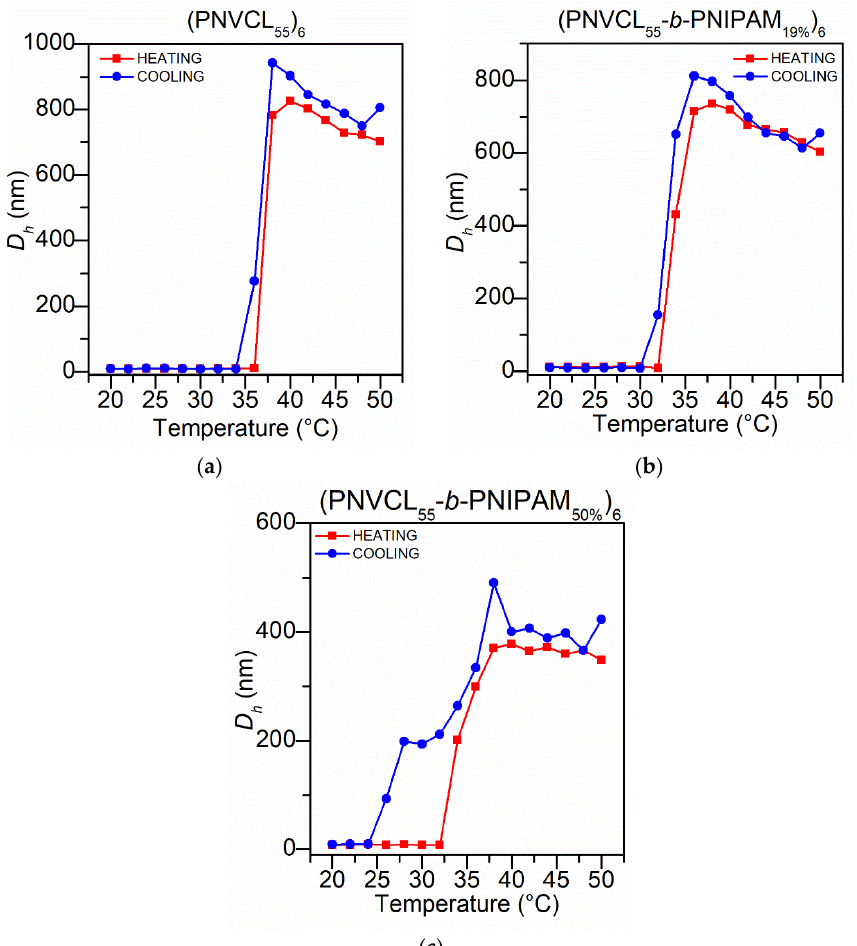
Figure 10. DLS measurements ( c = 1 mg/mL in water), evolution of the D h as a function of the temperature for ( a ) (PNVCL 55 ) 6 star polymers ( M n GPC = 46,120 g/mol, Ð = 1.12), ( b ) (PNVCL 55 - b -PNIPAM 19% ) 6 star block copolymers ( M n GPC = 47,320 g/mol, Ð = 1.27) and ( c ) (PNVCL 55 - b - PNIPAM 50% ) 6 star block copolymers ( M n GPC = 49,100 g/mol, Ð = 1.32). The red line represents the heating cycle and the blue line represent the cooling cycle. Heating and cooling rate: 1.0 °C/min.